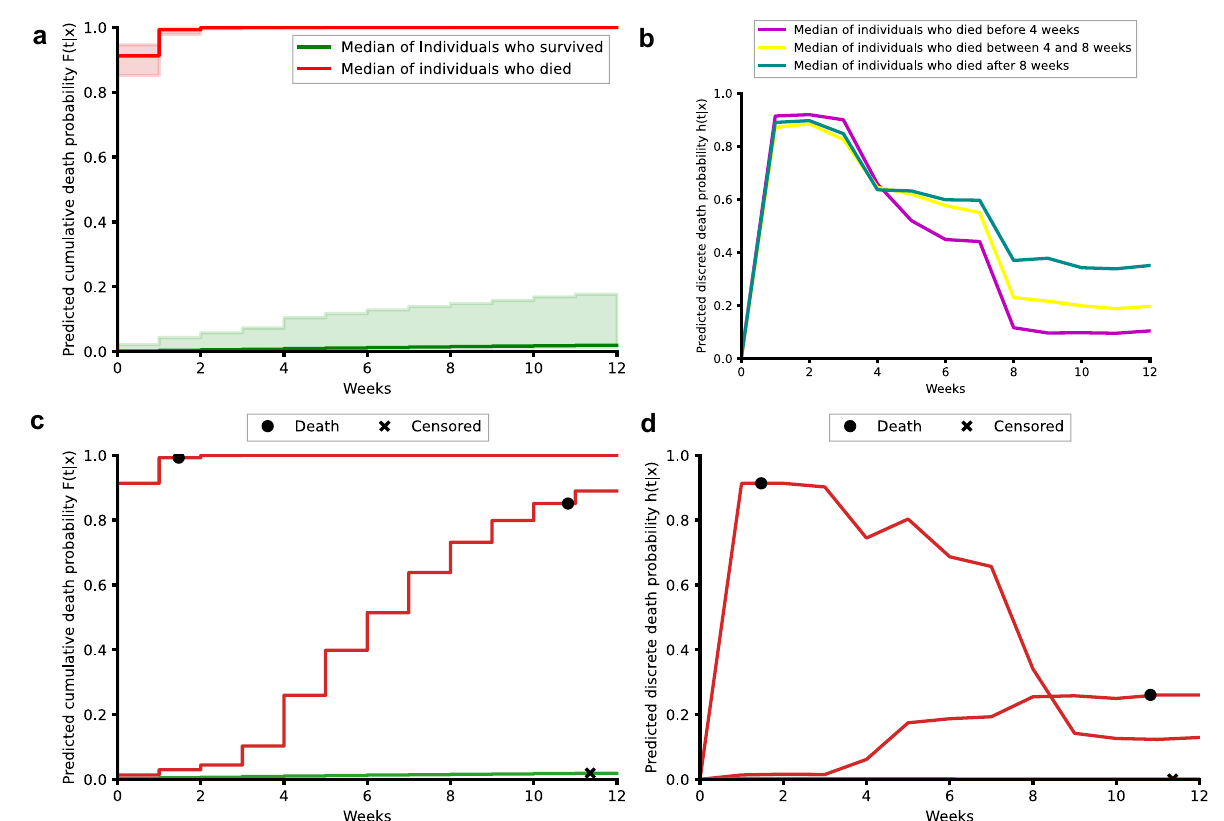
Figure 3. Predicted individual discrete and cumulative death probabilities. Weekly discrete and cumulative probabilities of death were predicted for all patients in the test set using data prior to their first positive test. Individual probabilities were summarized by the median, 80 and 20 percentiles for patients who died (red) or survived (green) ( a ). Predicted cumulative death probabilities were summarized by the median ( b ) for patients who died before 4 weeks (pink), between 4 and 8 weeks (yellow) and after 8 weeks (blue). Individual examples of predicted cumulative ( c ) and discrete ( d ) death probabilities for three patients are depicted indicating the time of death (black dot) or censoring